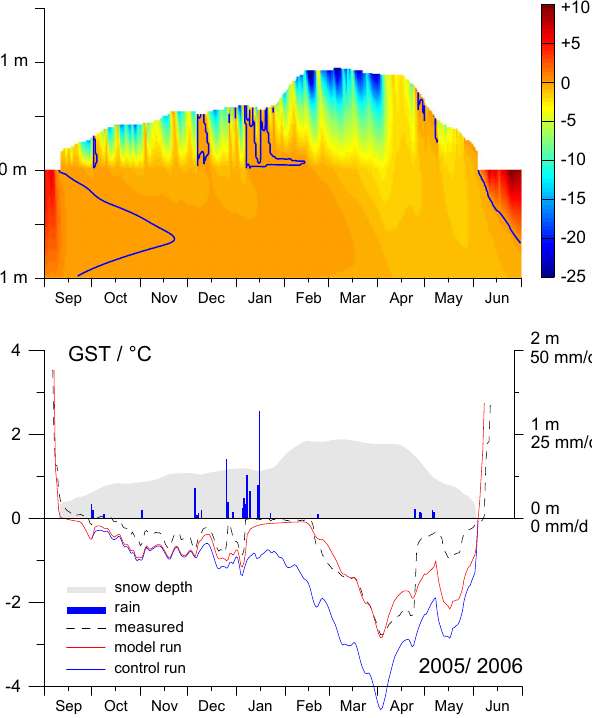
Fig. 5. Top: modeled temperature distribution (in ◦ C) within the snow pack and the first meter of soil for the winter season 2006/2007. The − 0.01 ◦ C isotherm is depicted in blue. Bottom: measured and modeled (including control run) ground surface tem- perature for the same time interval. In addition, the snow depth in m (right axis) and daily rainfall in mmd − 1 (as employed in the model runs) are